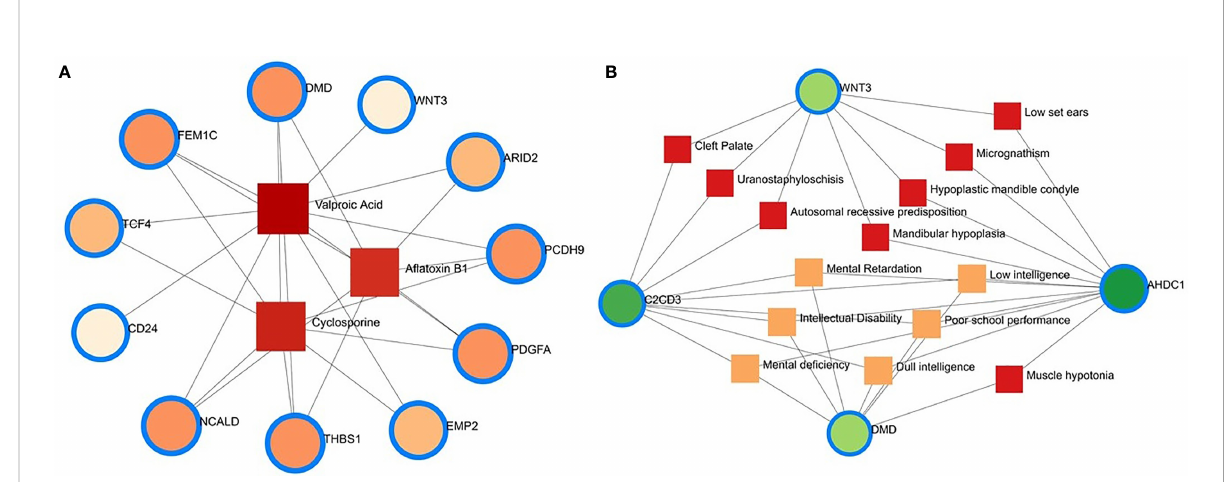
FIGURE 10 Protein-chemical and gene-disease association. (A) Protein-chemical interaction network. Three phytochemical compounds were found against 11 genes. Circles showed the shared DEGs, while square shapes indicated interacting phytochemical compounds. (B) Gene-disease association network. Circles indicate the common differential genes, and the 14 square shapes represent the common diseases interconnected to the COVID-19 patients.